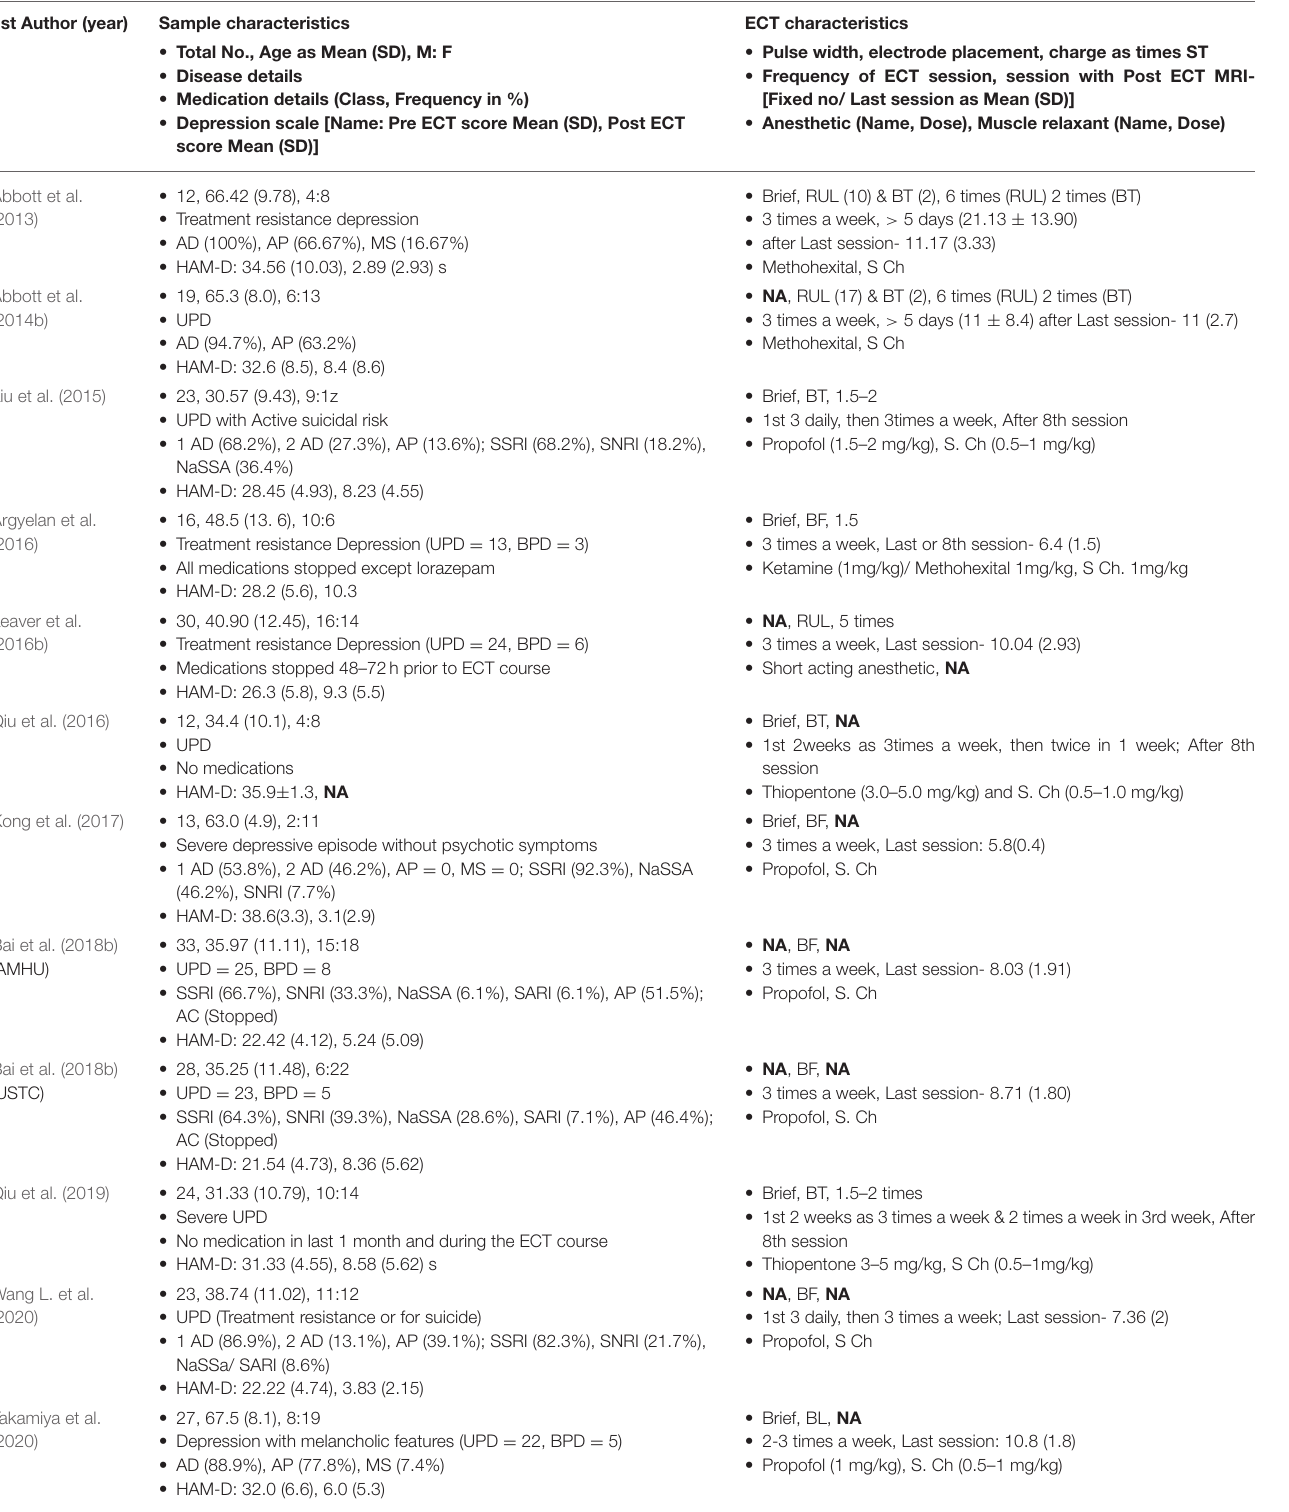
TABLE 4 | List of studies included in ALE analysis: clinical